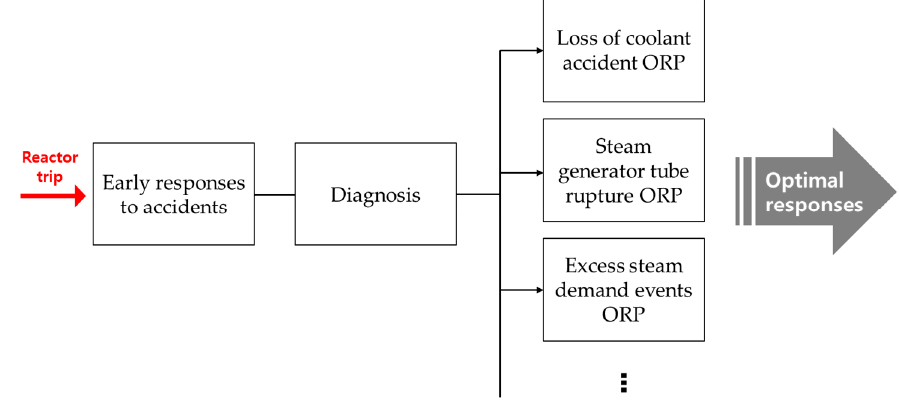
Figure 1. Emergency operating procedure (EOP) package (symptom-based).